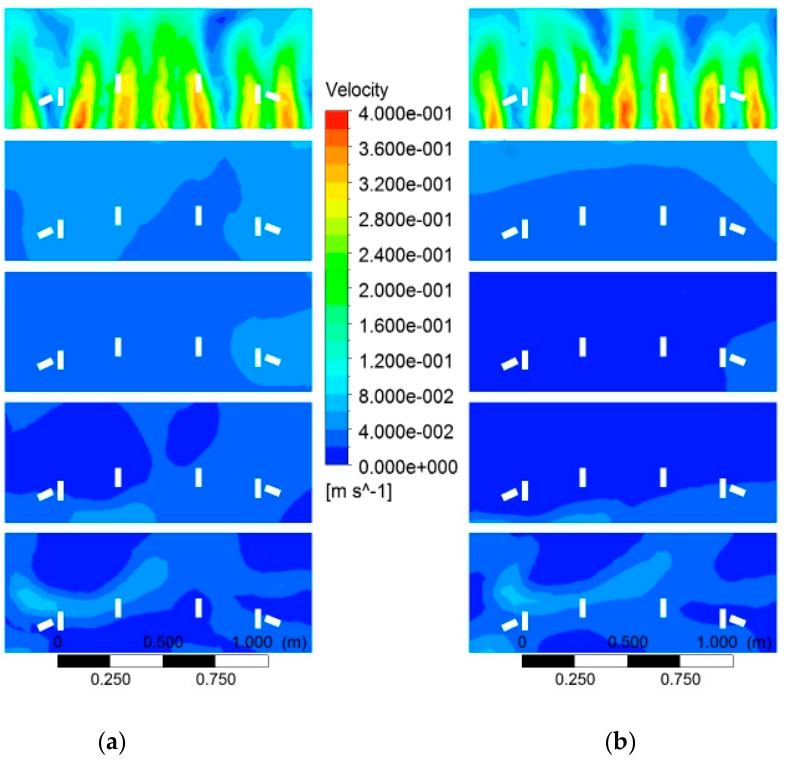
Figure 15. Computed velocity maps at frontal face areas of virtual boxes. ( a ) Original case and ( b ) Tank with shortened depth. Inlet oil velocity was 0.5 m/s.